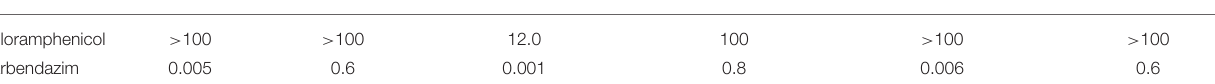
TABLE 4 | Drug sensitivity of N. parvum strains. Compound